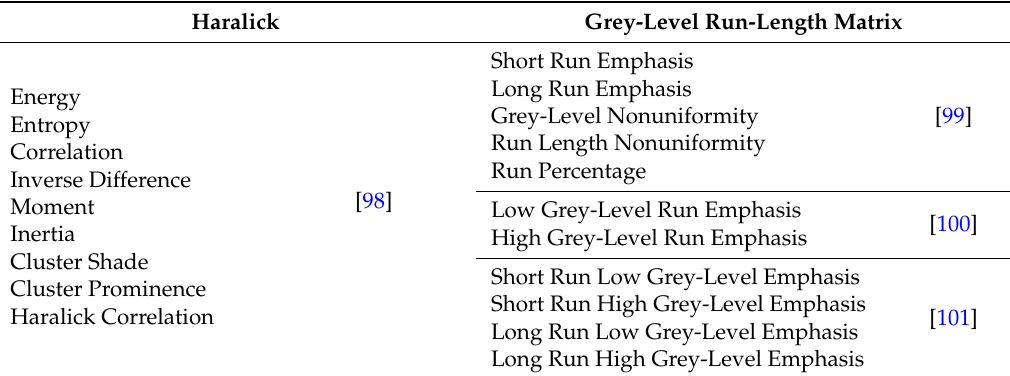
Table A2. Summary of textural features used in the